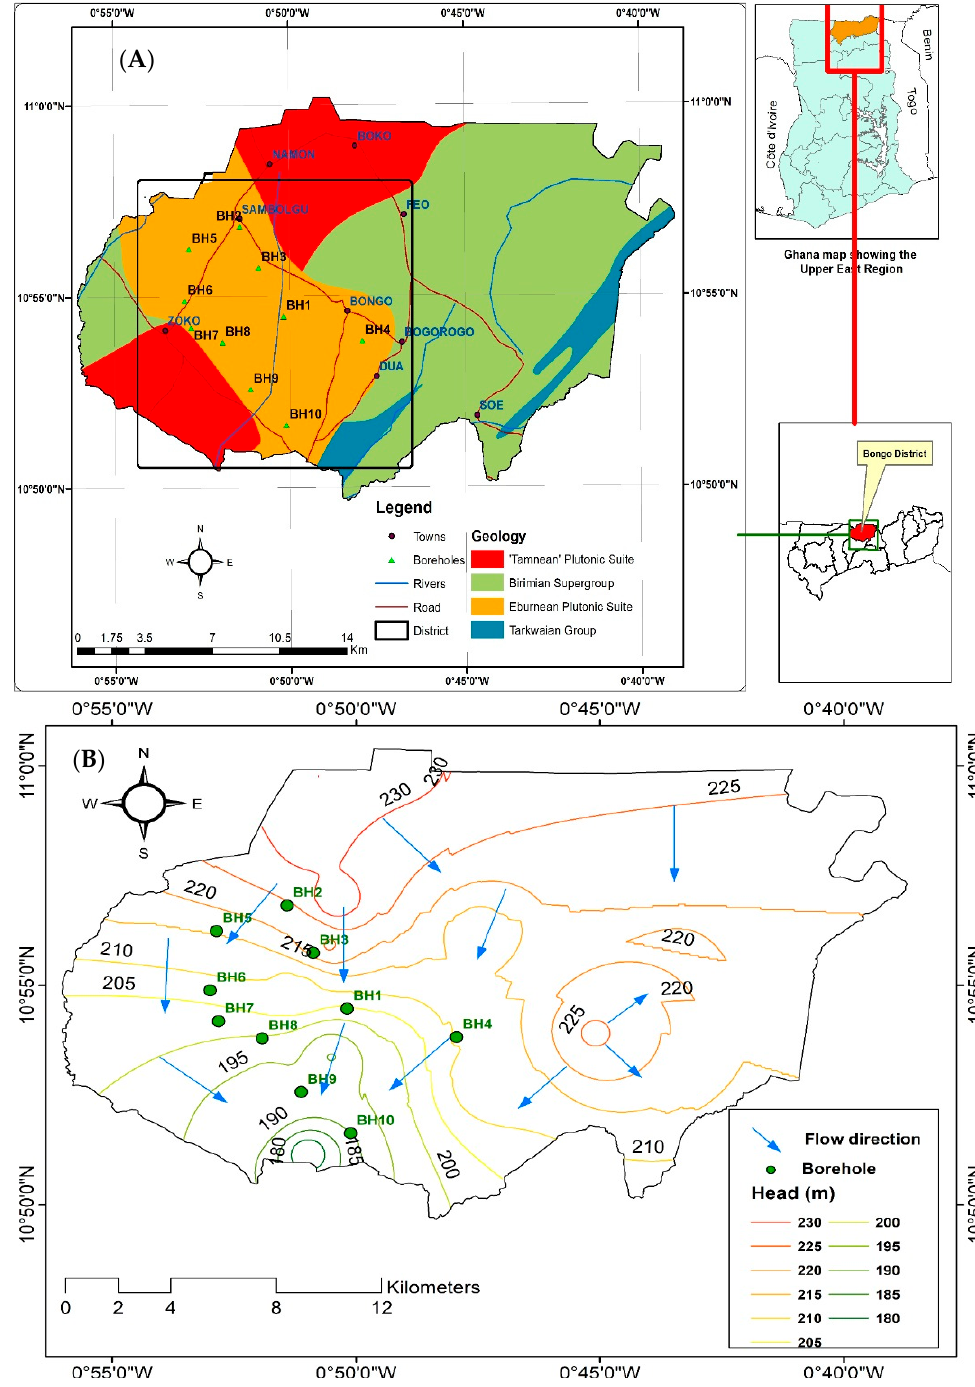
Figure 1. ( A ) Location and simplified geology map, and ( B ) groundwater level contour map showing the groundwater flow direction (arrows) in the study area.